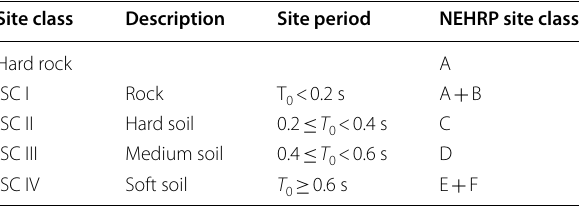
Table 2 Site classification based on fundamental site period and corresponding NEHRP site classes (after Zhao et al. 2006)